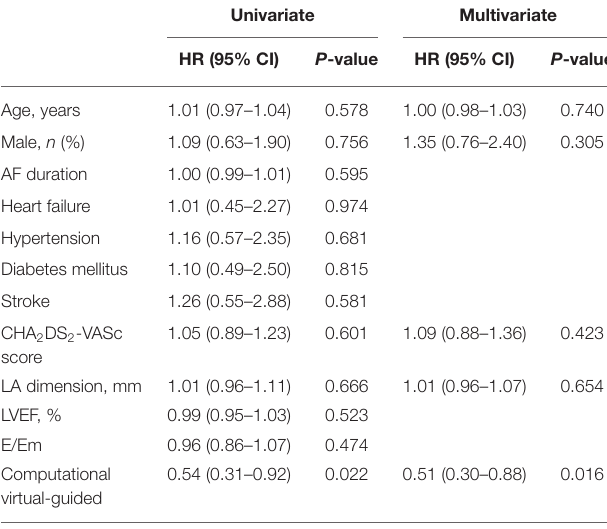
TABLE 2 | Cox regression analysis for clinical recurrence after catheter ablation. Univariate